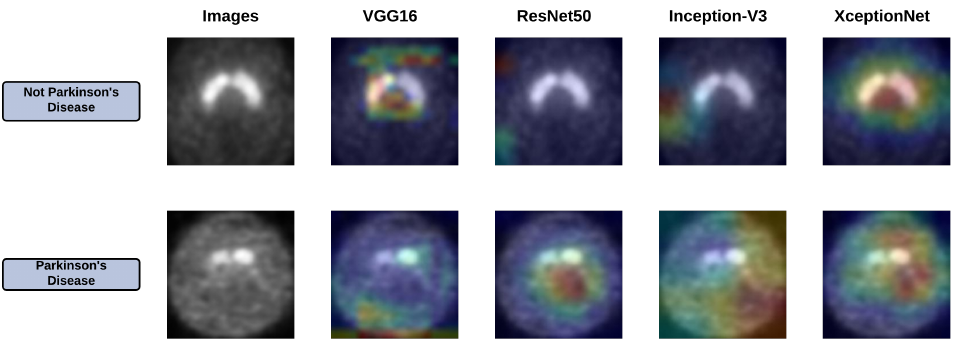
Figure 10. Grad-Cam of all the base